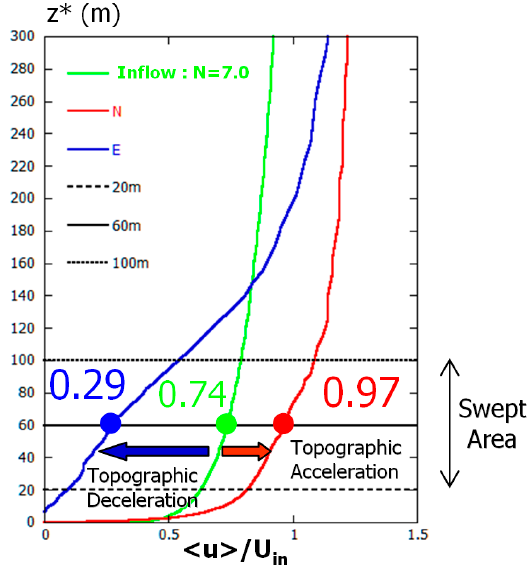
Figure 22. Vertical profiles of the streamwise wind velocity at wind turbine #10, with a time-averaged flow field. Red: northerly wind, Blue: easterly